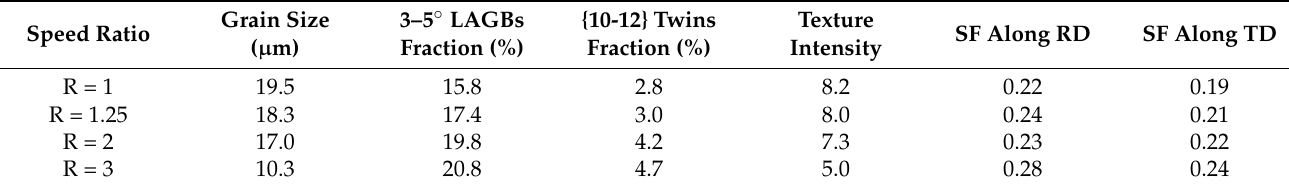
Table 2. Microstructure and texture characteristic of the as-rolled Mg-6Sn sheets based on EBSD. Grain Speed Ratio